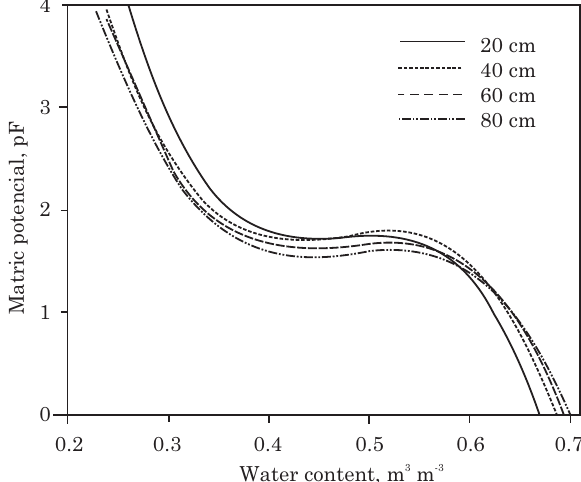
Figure 2. Soil water retention curves adjusted by the cubic polynomial model for Oxisol at depths of 20, 40, 60, and 80